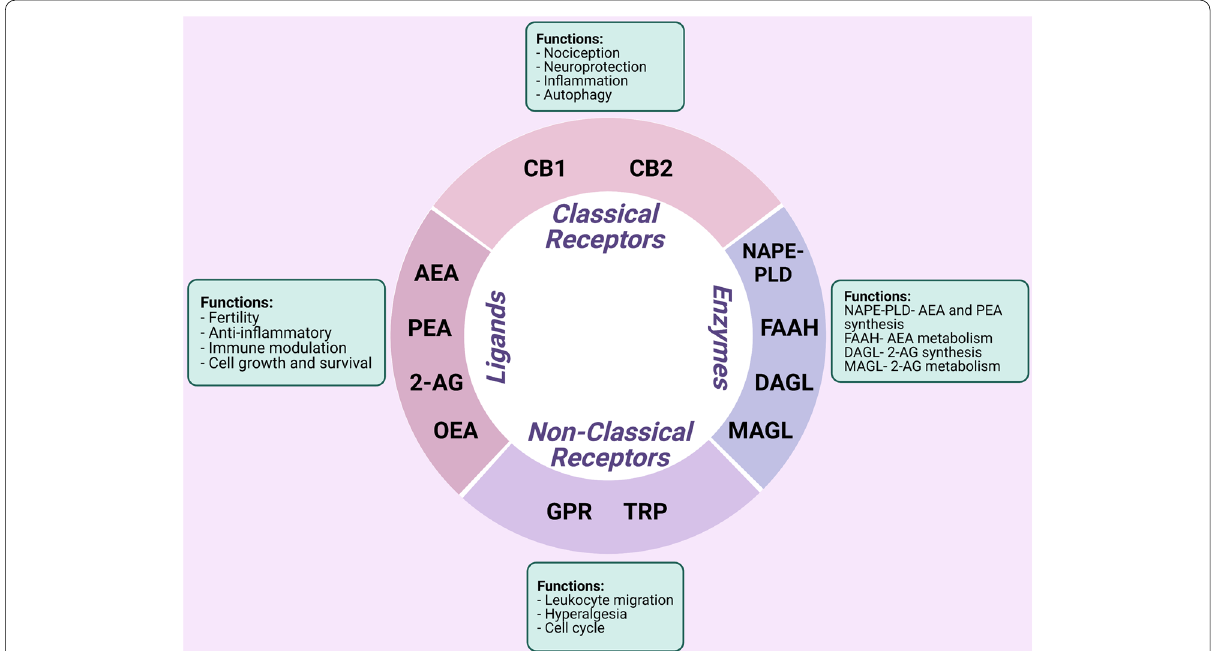
Fig. 1 Summary of the role of the endocannabinoid system in the context of endometriosis. Cannabinoid receptors 1 (CB1) and 2 (CB2) are considered as classical receptors and orphan G protein-coupled receptors (GPRs) and transient receptor potential (TRP) channels as nonclassical receptors of the endocannabinoid system (ECS). Arachidonoylethanolamine (AEA) and 2-arachidonoylglycerol (2-AG) are the predominant molecules of the ECS, while palmitoylethanolamide (PEA) and oleoylethanolamide (OEA) are found in a lesser extent. Molecules of the ECS are biosynthesized by, but not limited to, N-acylphosphatidylethanolamine phospholipase D (NAPE-PLD) and diacylglycerol lipase (DAGL) depending on the microenvironment. Degradation of the endocannabinoids (ECs) by fatty acid amide hydrolase (FAAH) and monoacylglycerol lipase (MAGL) is rapid. Together, the ECS is involved in a variety of physiological processes such as nociception, inflammation, and immune